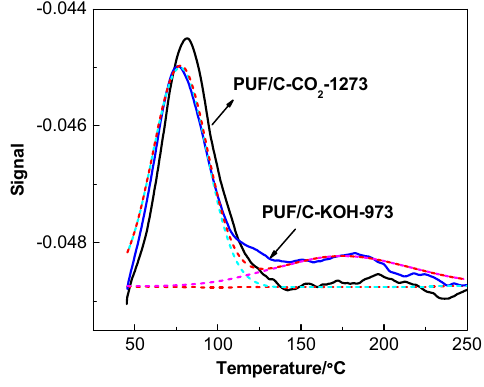
Figure 6. CO 2 - temperature-programmed-desorption (TPD) profile of PUF/C-KOH-973 and PUF/C- CO 2 - temperature-programmed-desorption (TPD) profile of PUF / C-KOH-973 and CO 2 -1273. PUF / C-CO 2